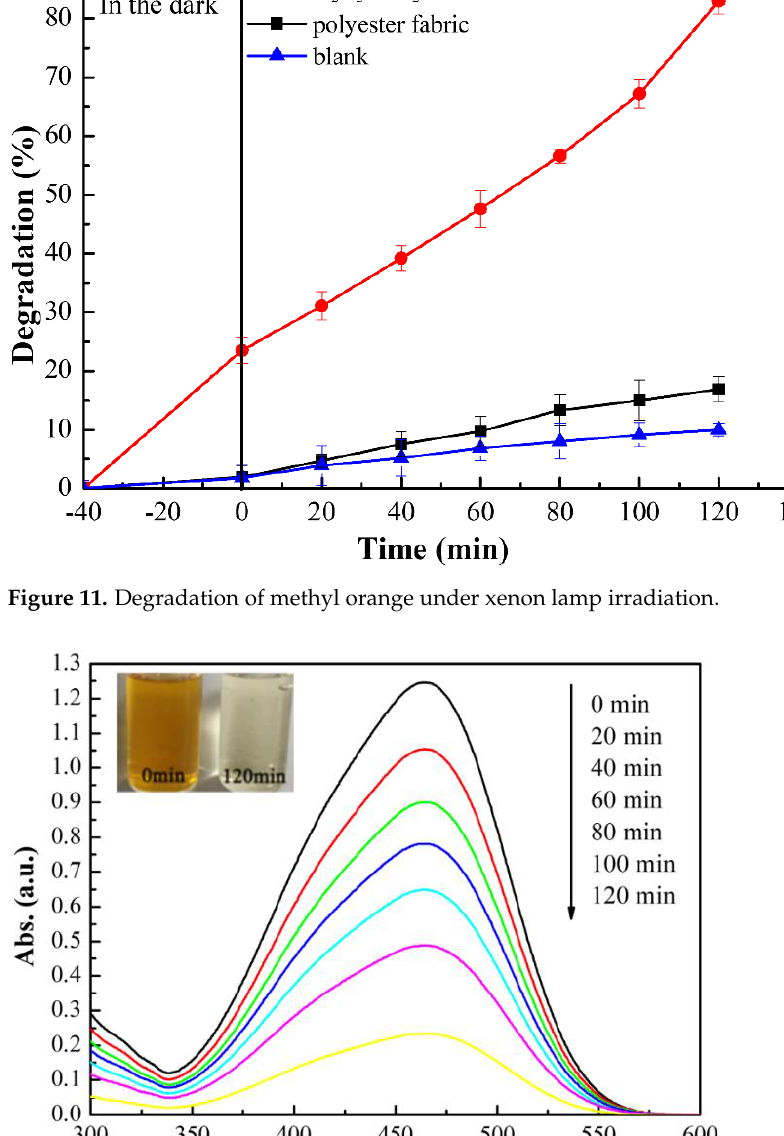
Figure 11. Degradation of methyl orange under xenon lamp irradiation.